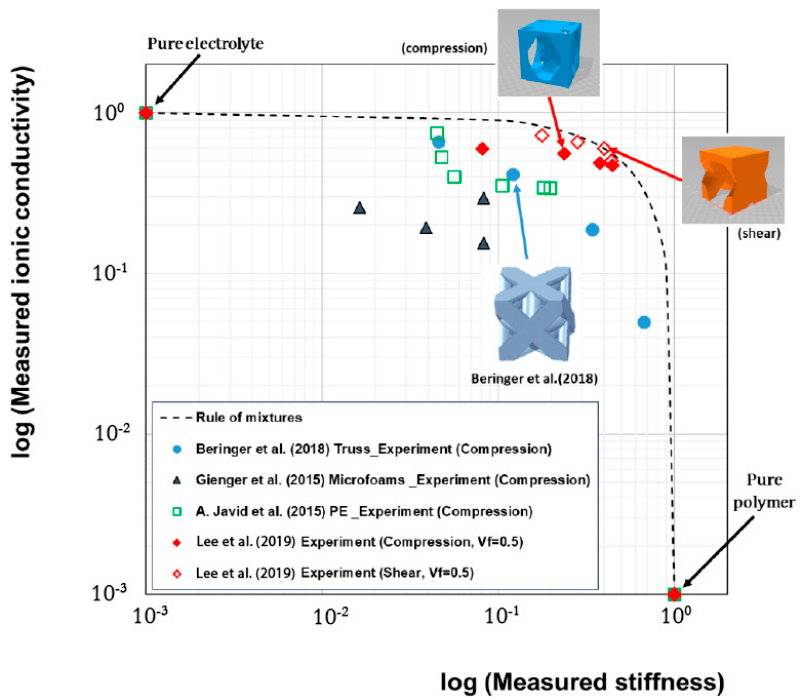
Figure 25. Performance of multifunctional engineered unit-cells from Lee et al. [26]. (N.B. the stiffnesses and ionic conductivities were normalized against the stiffness of a pure solid polymer and the ionic conductivity of a pure electrolyte, respectively).